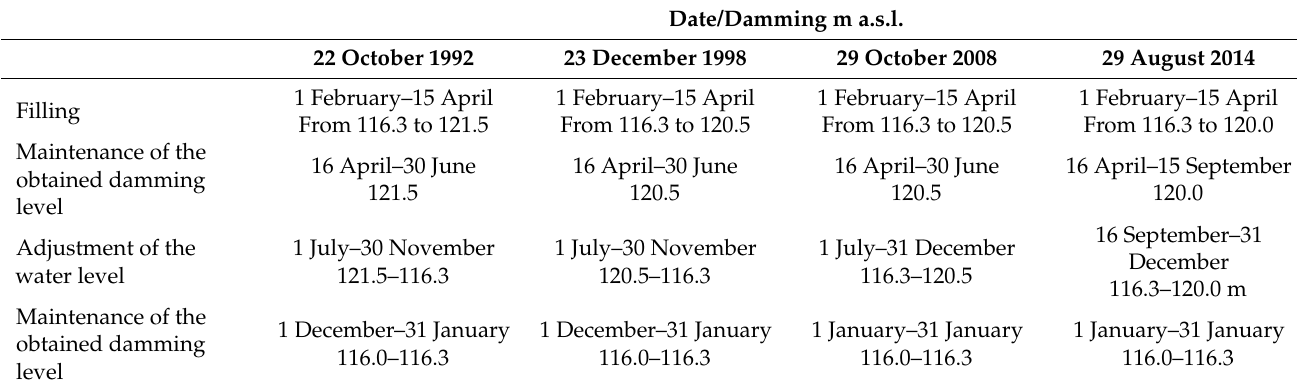
Table 1. Dates and damming levels of the Jeziorsko reservoir. Date/Damming m